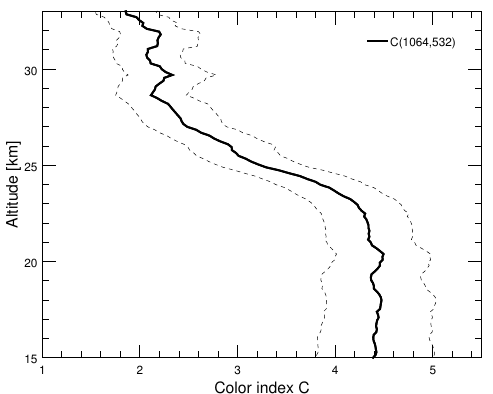
Figure 2. Color index profile calculated from monthly mean backscatter ratio profiles at the wavelengths of 1064 nm and 532 nm for March 2013 and using Equation (10). The thick line represents the mean value and the dashed lines indicate the error band calculated by Gaussian error propagation of the error of the mean backscatter ratio